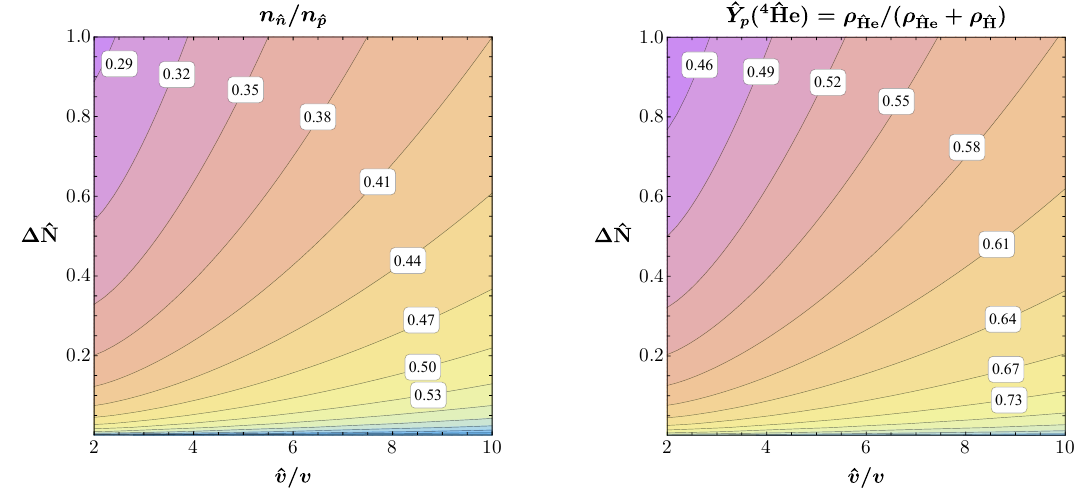
Figure 3. The twin neutron to twin proton fraction (left) and the primordial abundance of twin helium (right) obtained from twin